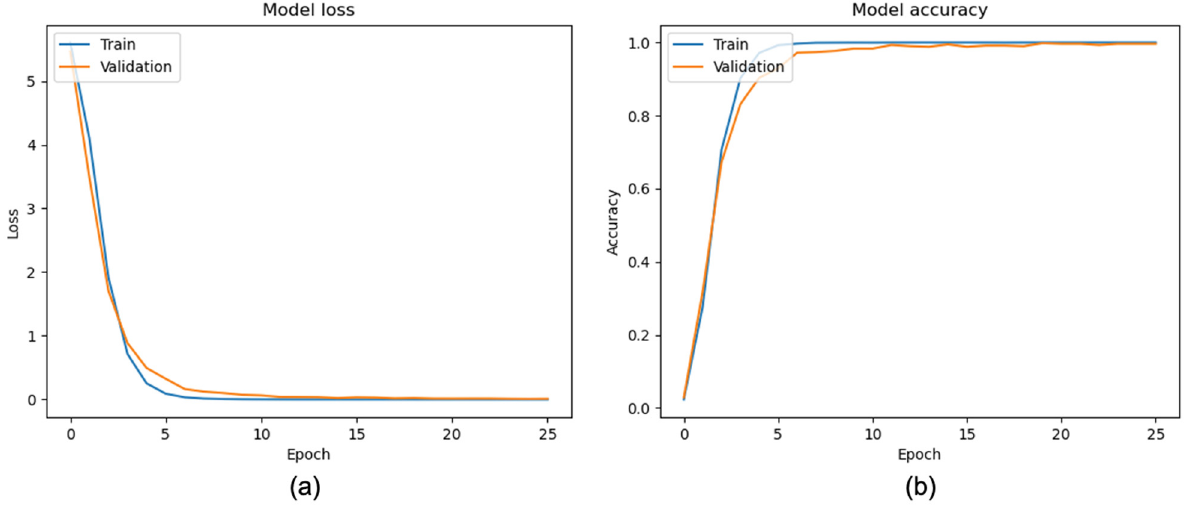
Figure 5. Learning curves of the proposed model on training and validation datasets. ( a ) Loss vs. Epochs, and ( b ) Accuracy vs. Epochs.